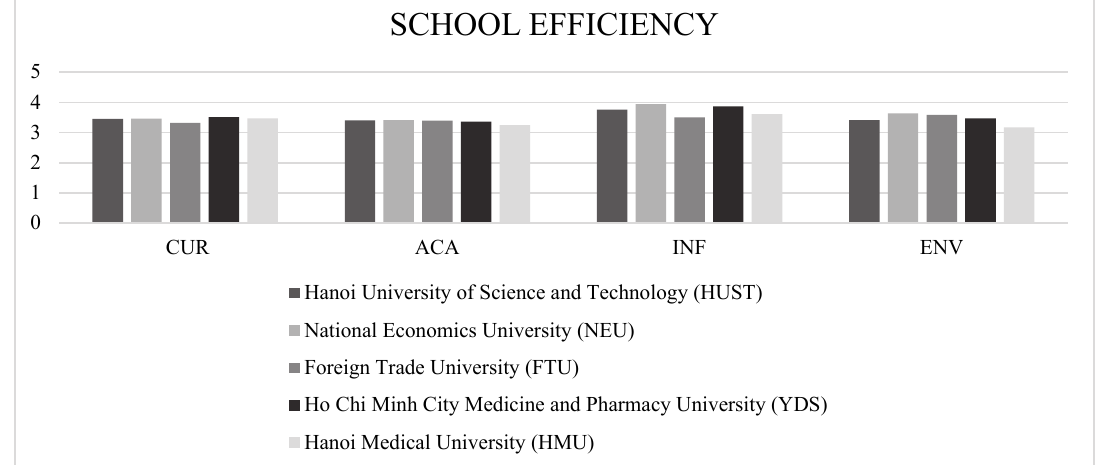
Fig. 2. Independent variables of 5 universities